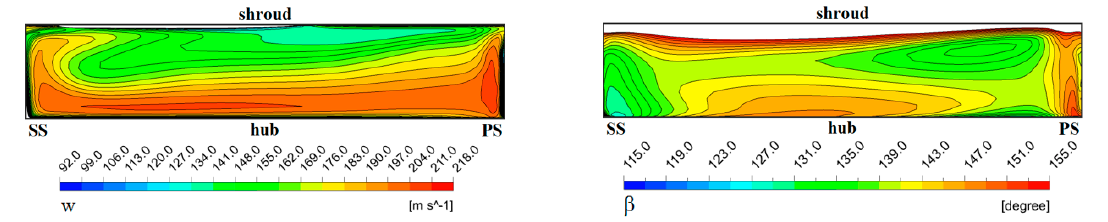
Figure 11. Vorticity in three hub-to-shroud surfaces of the impeller, point P1. PVS—passage vortex at shroud; BVS and BVP—blade surface vortices at SS and PS; CV—Coriolis vortex.